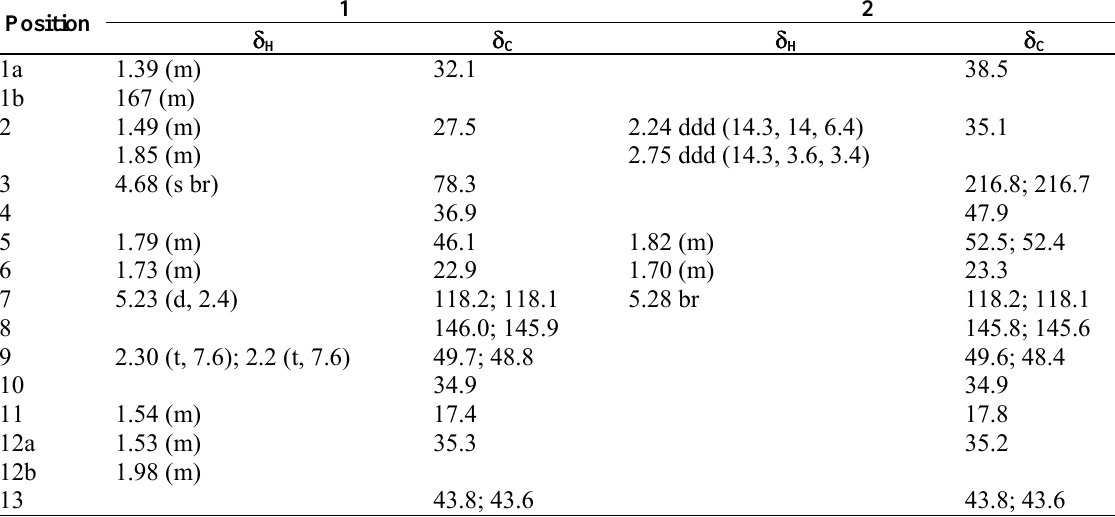
Table 2. 1 H- and 13 C-NMR data for compounds 1 - 2 (CDCl